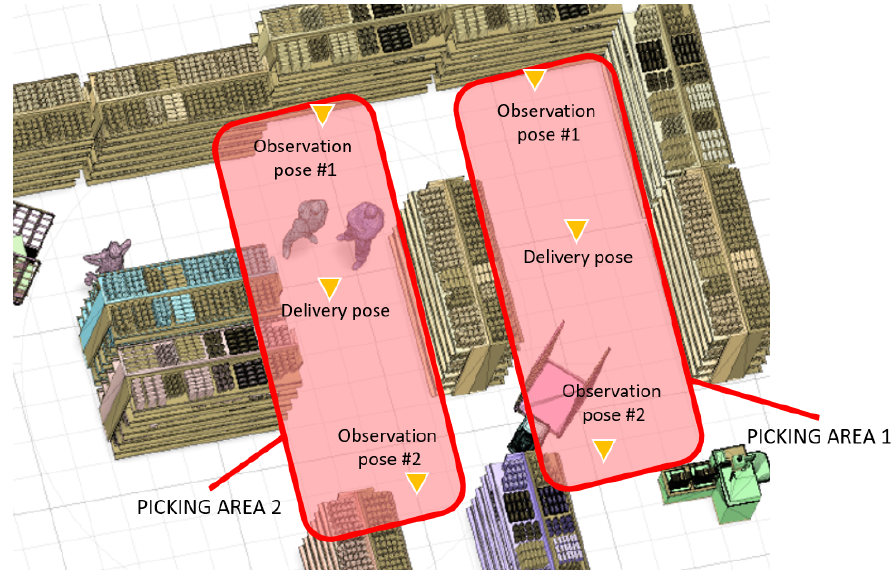
Figure 8. Key poses set in two picking areas in the